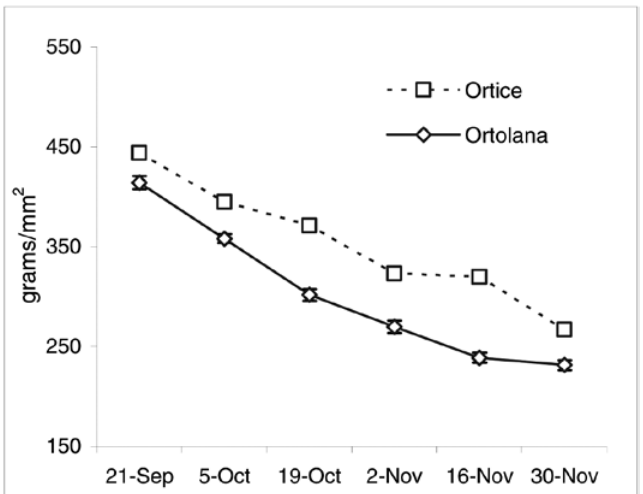
Fig. 3 - Evolution of pulp firmness during maturation (mean ± standard error).